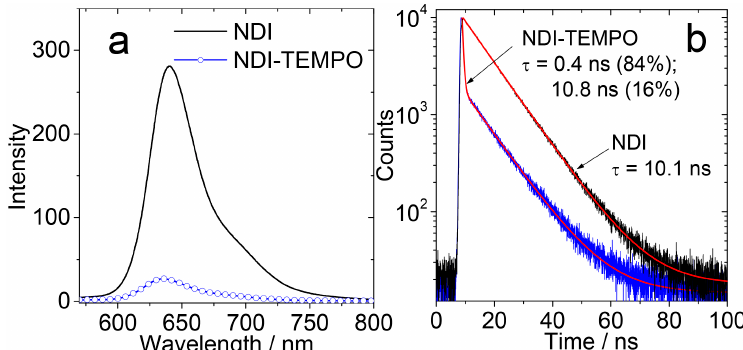
Figure 4. ( a ) Fluorescence emission spectra of NDI and NDI-TEMPO in toluene, λ ex = 560 nm. Optically matched solutions were used, c ≈ 1.0 × 10 − 5 M. ( b ) Fluorescence decay curves of NDI and NDI-TEMPO in toluene. c = 1.0 × 10 − 5 M, λ ex = 635 nm, 20 °C. Reproduced with permission from reference [41], copyright 2018, Wiley-VCH.